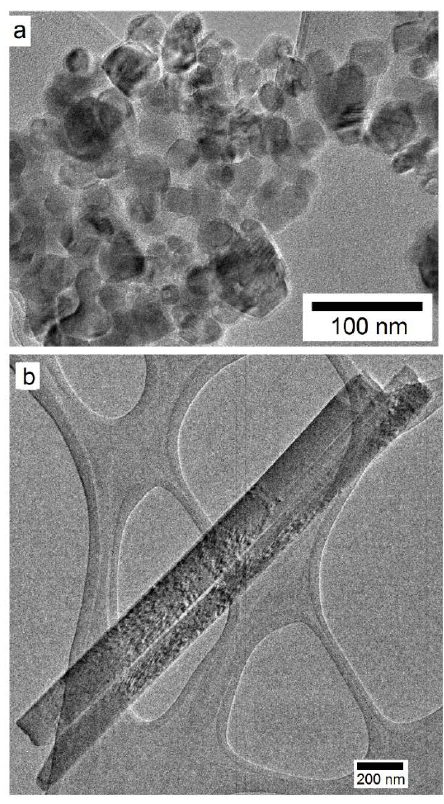
Figure 3. TEM microstructures of: ( a ) TiO 2 nanoparticles (NP); ( b ) TiO 2 nanowires (NW), used as nanoscale filler in the as-received PC grade.